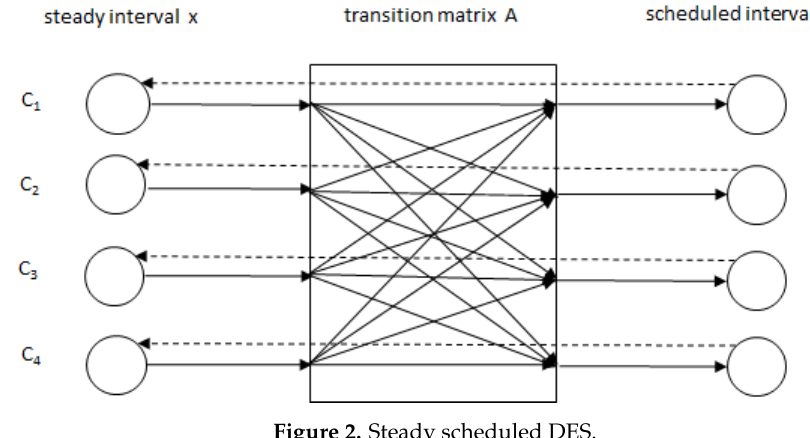
Figure 2. Steady scheduled